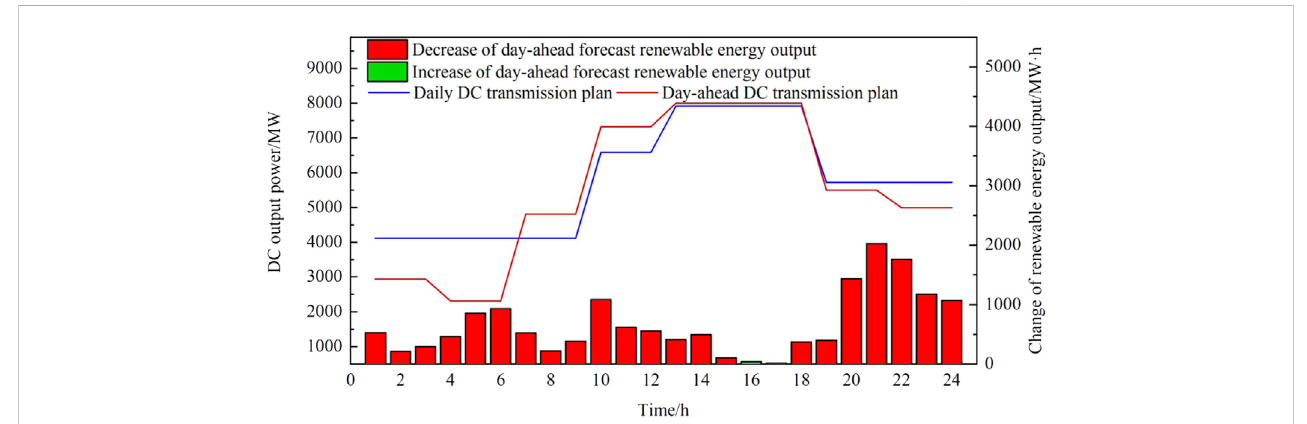
FIGURE 4 Day-ahead optimization results of July 1.